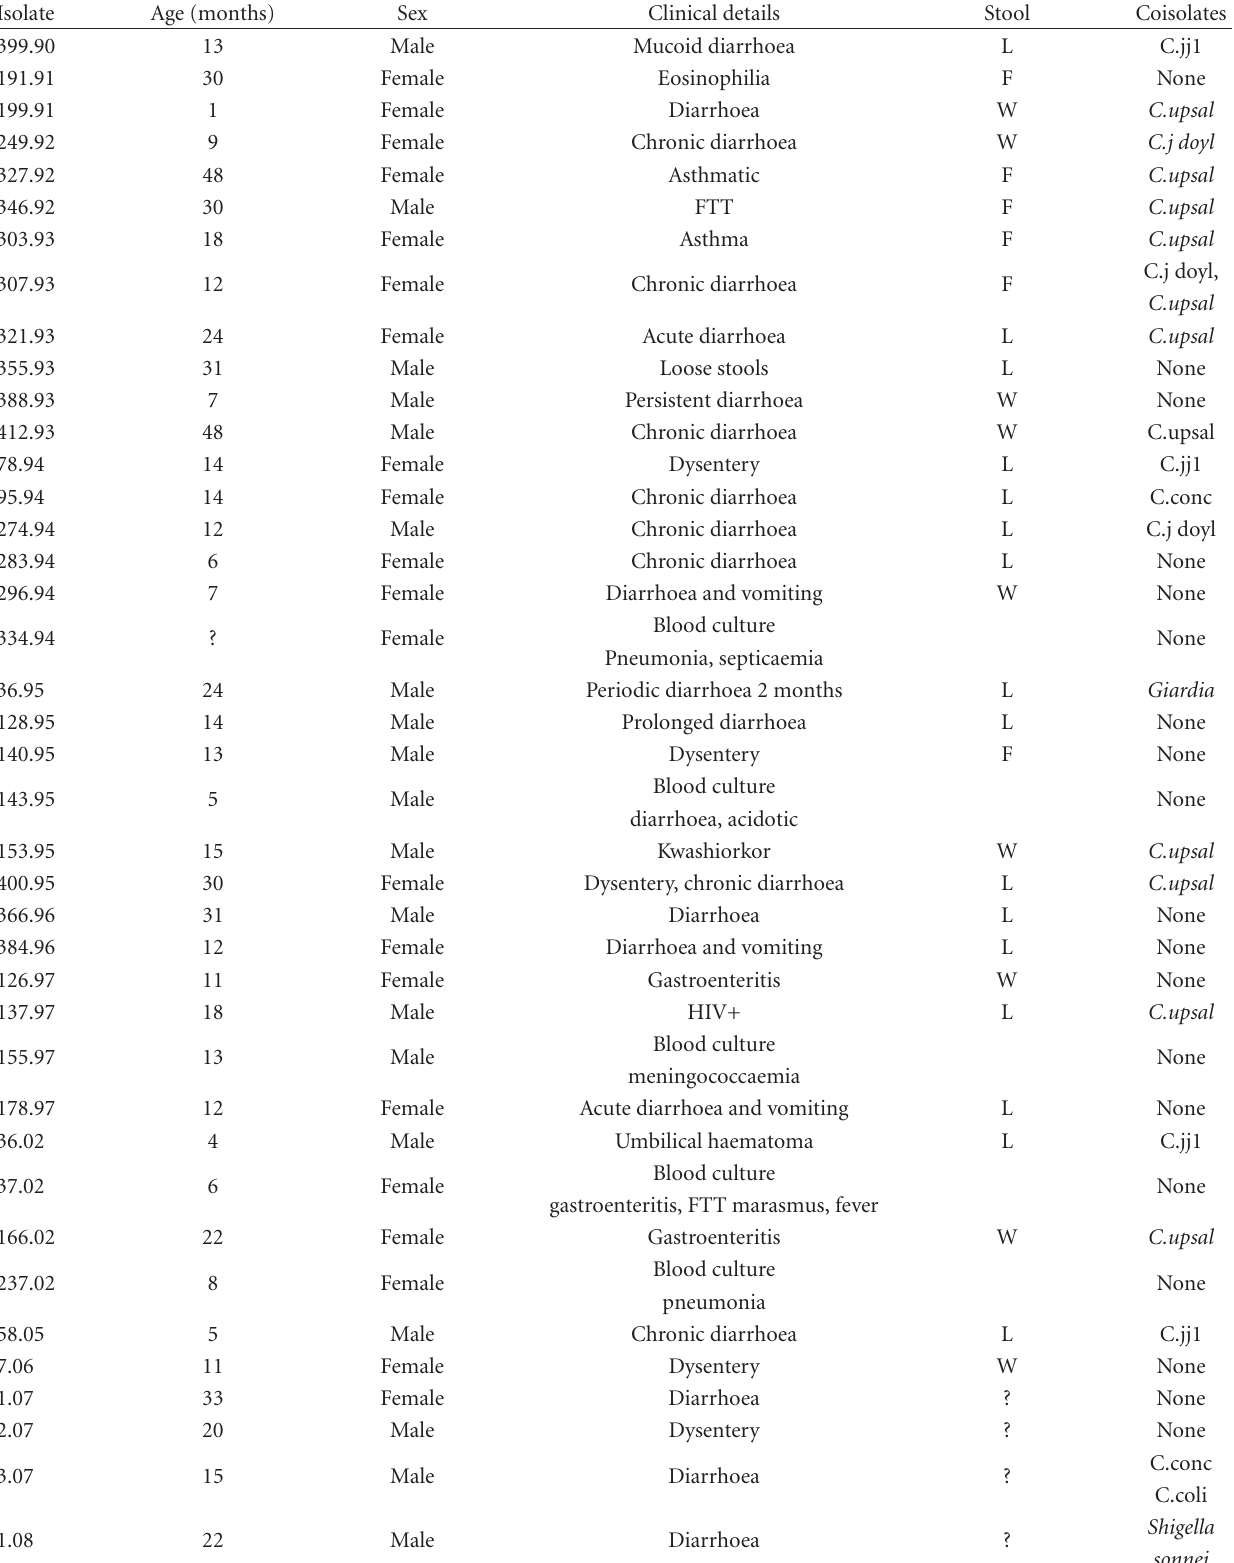
Table 1: Clinical and demographic details of the H. fennelliae isolates from paediatric stool and blood cultures.